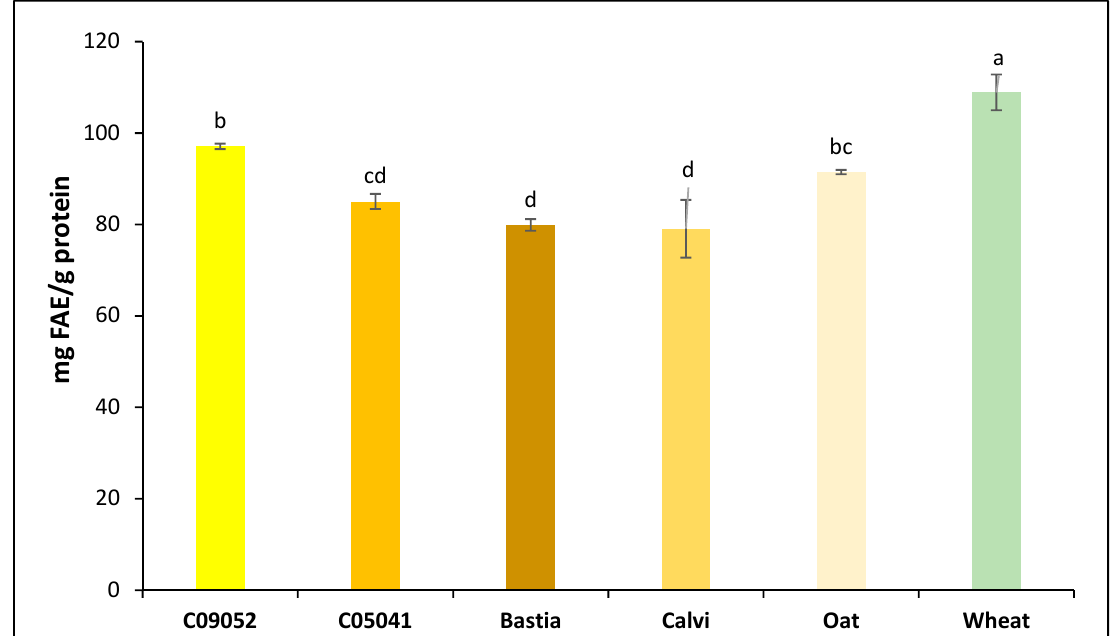
Figure 3. Comparison of total polyphenol content (TPC) of canaryseed, oat and wheat peptide permeates prepared following flours in vitro gastrointestinal digestion and 3K MWCO ultrafiltration, Data were expressed as ferulic acid equivalents (FAE). Different letters represent statistical difference according to the Tukey test with a confidence level of 95%. Values represent means ± SD ( n = 3).